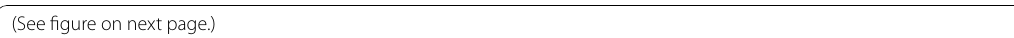
(See figure on next Fig. 3 Subaquatic channel structures of Lütschine ( A , C , E ) and Aare Delta ( B , D , F ). A, B: Zoomed section of backscatter-intensity map. C , D : Hillshade with colours indicating different branches of the channels and solid black lines showing profiles (p1–p8) across the channels. E , F : Cross-sections of channels (p1–p8) at various depths (5-times vertically exaggerated). G Profiles along channel thalweg (5-times vertically exaggerated) marked as dashed lines in C - D